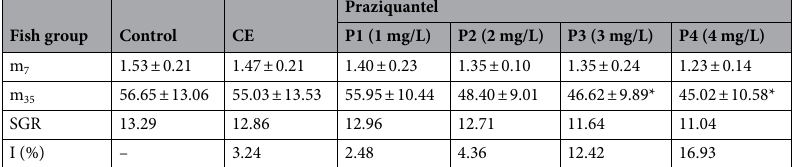
Table 2. Growth indices of carp during 35 days exposure of praziquantel. m 7 , m 31 = Mean carp weight in group after 7 and 35 days exposure (Mean ± SD, mg); SGR = specific growth rate in group after 28 days exposure; I = inhibition of specific growth in selected group after 28 days exposure; SD = standard deviation. *Significantly ( P < 0.01) difference between experimental and the control group. Groups: CE (solvent control, contained ethanol 0.8 ml/L), P1 (praziquantel 1.0 mg/L), P2 (praziquantel 2.0 mg/L), P3 (praziquantel 3.0 mg/L) and P4 (praziquantel 4.0 mg/L).